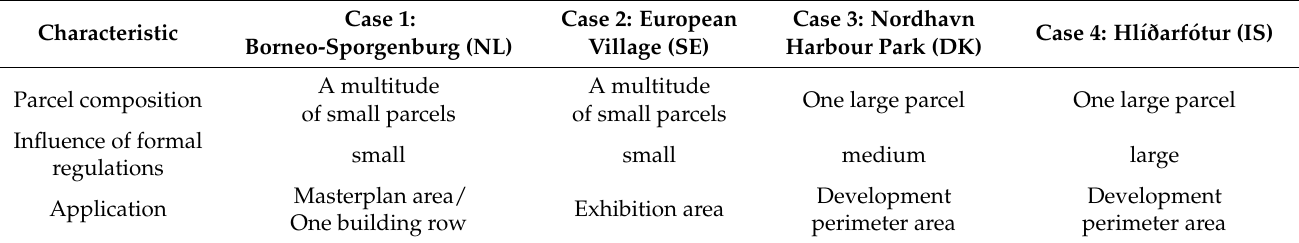
Table 1. Overview of the characteristics of the case